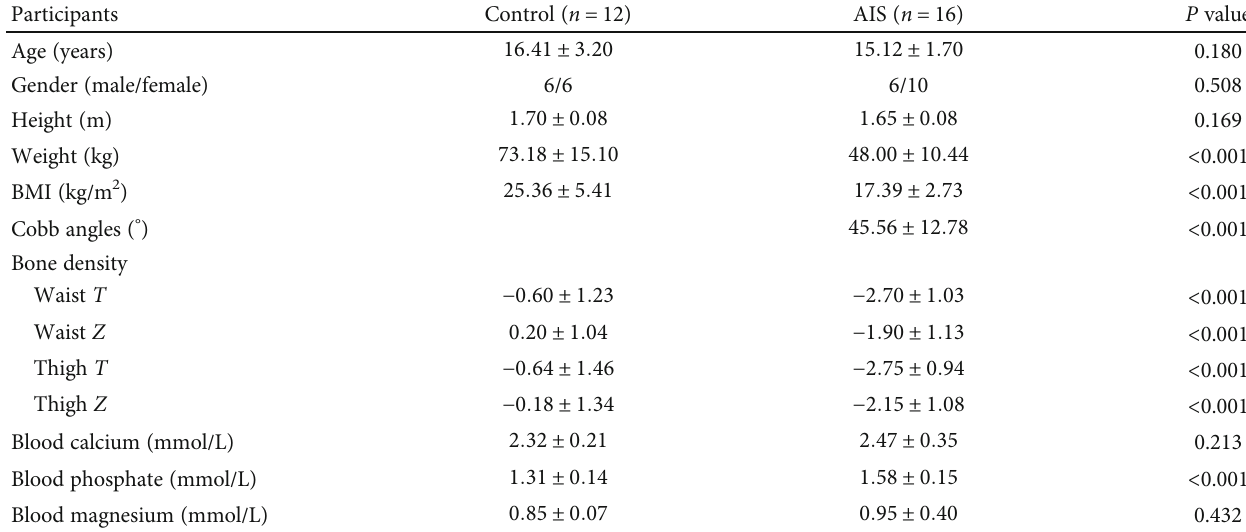
Table 1: Clinical information of the